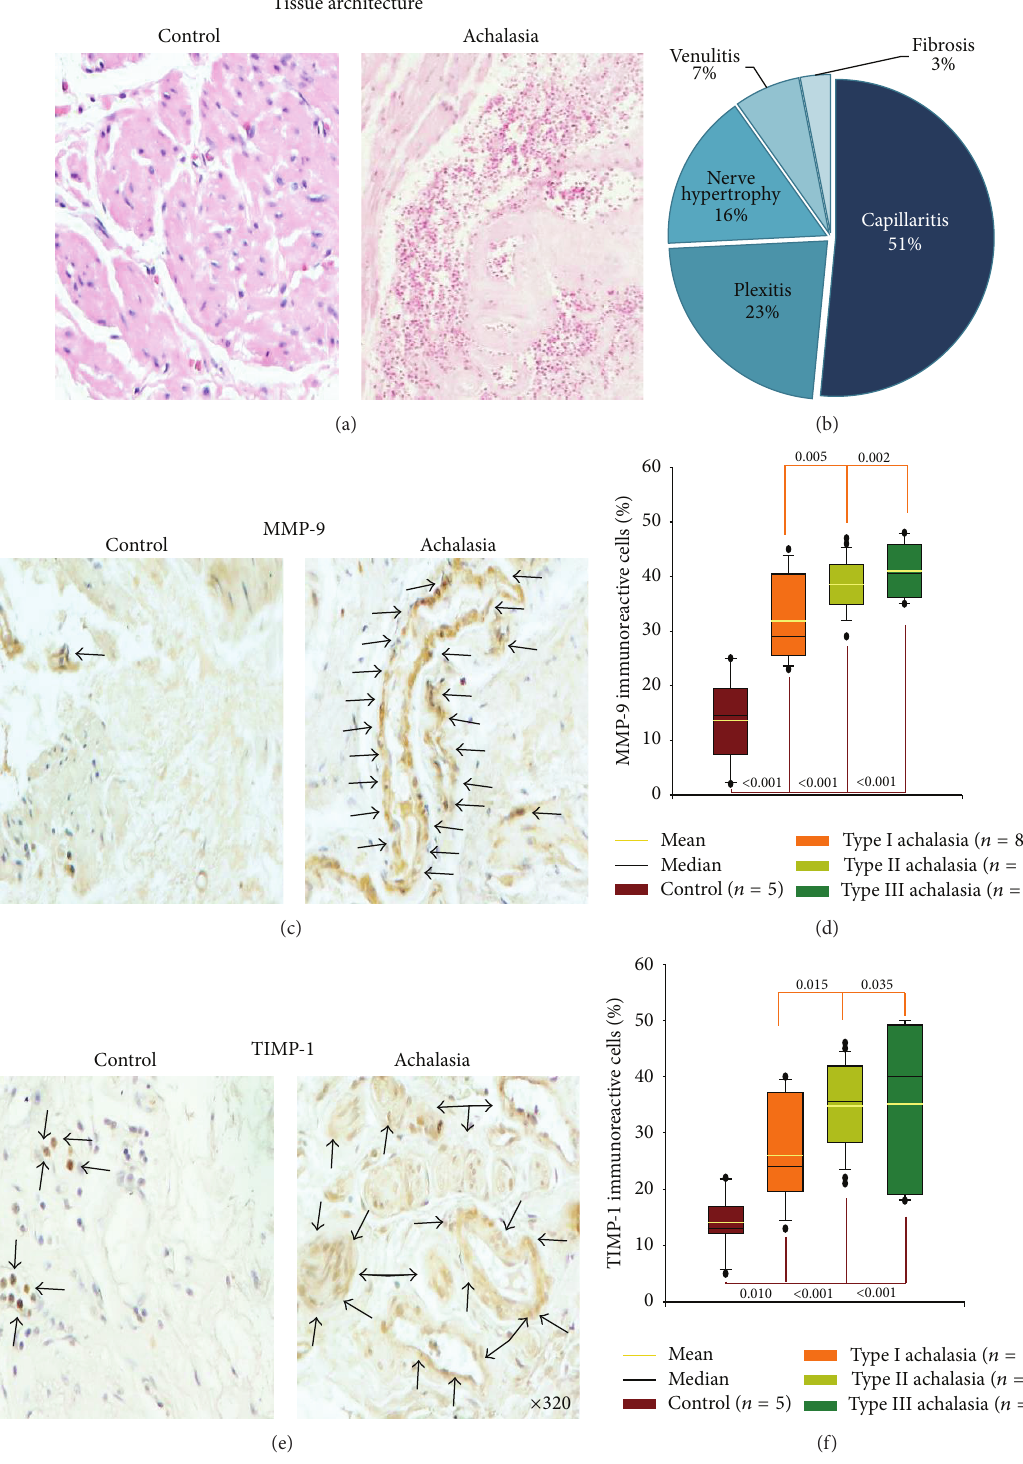
Figure1:Proteinsinvolvedinextracellularmatrixturnoverinachalasia.(a)Representativephotomicrographfromacontrolandanidiopathic achalasia tissue in which an abundant inflammatory infiltrate is observed. Original magnification was × 200. (b) Histological findings in biopsies from achalasia patients. (c) Immunoreactive cells. Original magnification was × 320. (d) Results are expressed as mean (yellow line), median (black line), and 5th/95th percentiles of MMP-9 + cells. (e) Immunohistochemistry for TIMP-1 in control and achalasia sections. Arrows depict immunoreactive cells. Original magnification was × 320. (f) Results are expressed as mean (black line), median (yellow line), and 5th/95th percentiles of TIMP-1 +